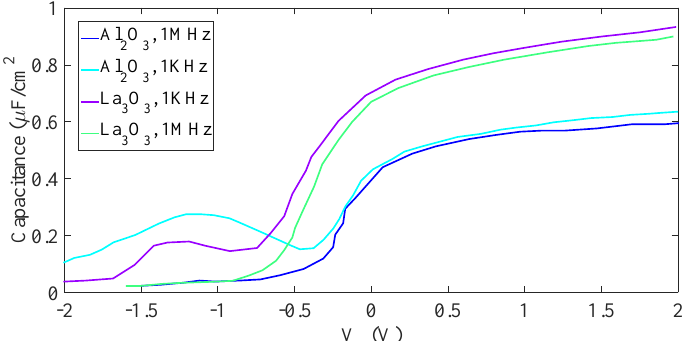
Figure 4. Capacitance voltage (CV) curves of different materials at 1 KHz and 1 MHz frequencies (AC analysis).